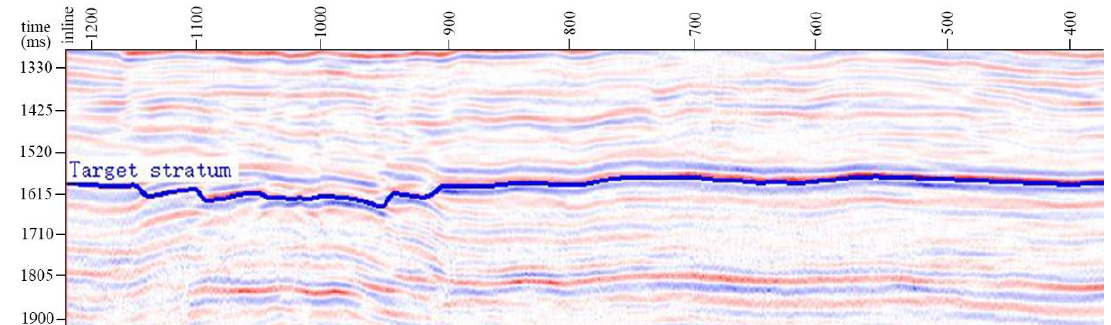
Figure 4. Seismic profile of the arbitrary x-line in Figure 3, which is close to the target stratum. The stratum fractures frequently in the northern region and is very gentle in the south.